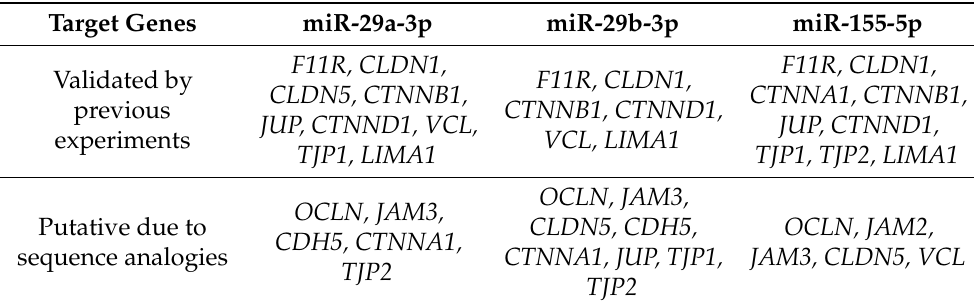
Table 2. Target genes of miR-29a-3p, miR-29b-3p, and miR-155-5p were identified using the databases miRWalk2.0 and DIANA-TarBase